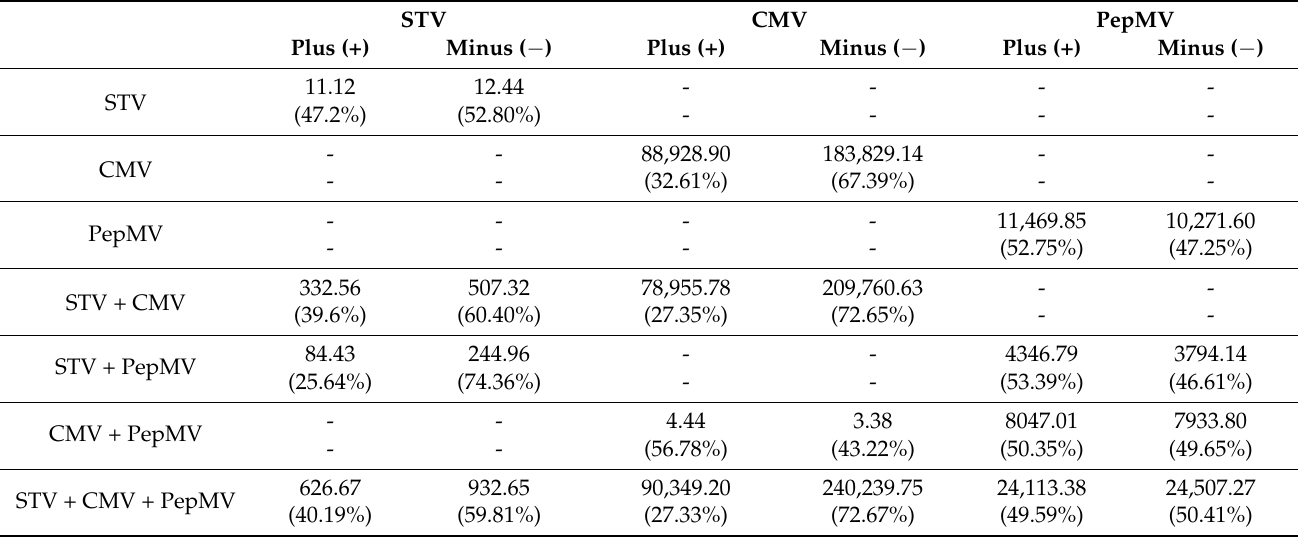
Table 2. siRNAs polarity (plus or minus) in tomato plants infected with de different STV, CMV, and PepMV virus combinations. The numbers for each virus combination correspond to the mean of the biological replicates. The percentages of plus (+) and minus ( − ) vsiRNAs polarity base on the useful reads are in